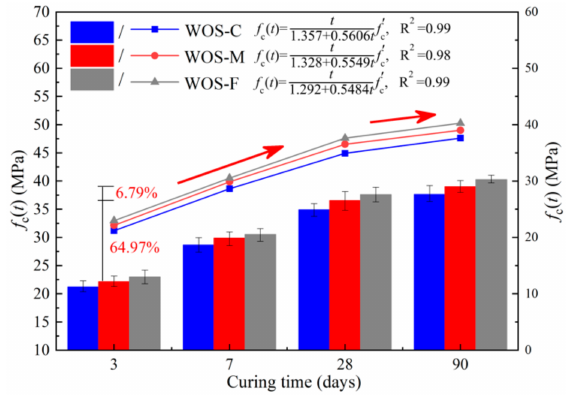
Figure 6. The effect of particle size of WOS on the f c ( t